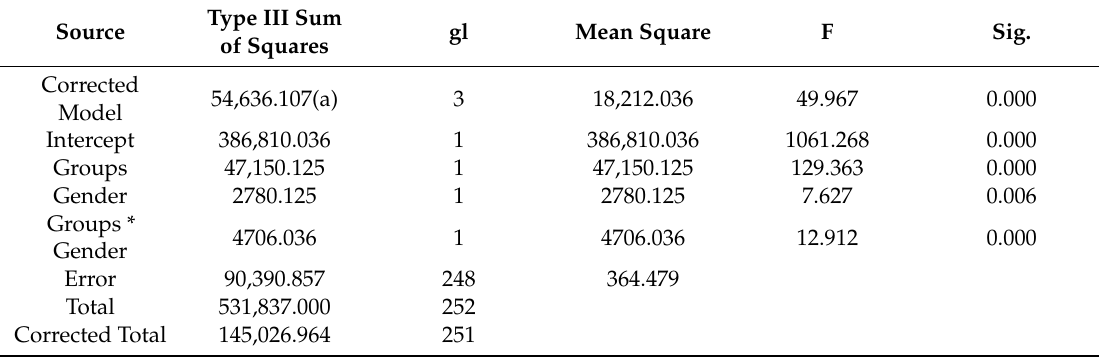
Table 5. Two-way ANOVA: Time taken to play musical chords.